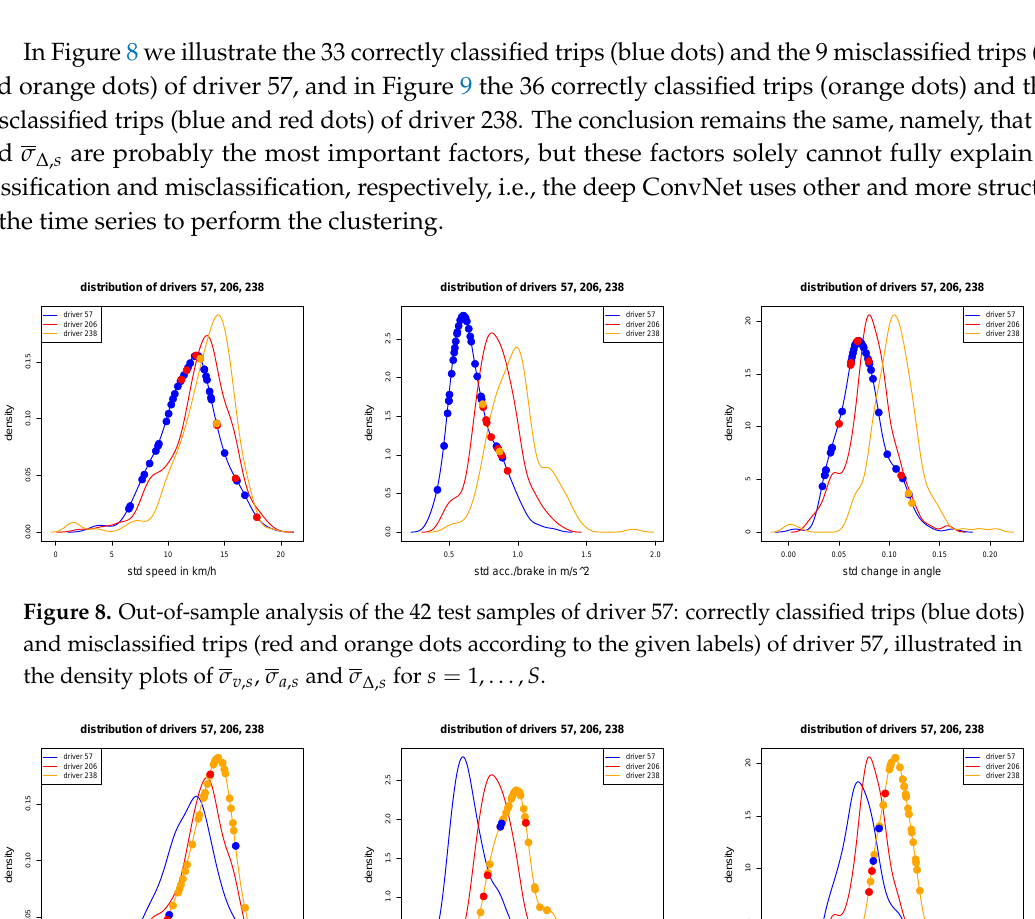
Figure 9. Out-of-sample analysis of the 42 test samples of driver 238: correctly classified trips (orange dots) and misclassified trips (blue and red dots according to the given labels) of driver 238, illustrated in the density plots of σ v , s , σ a , s and σ ∆ , s for s = 1, . . . , S